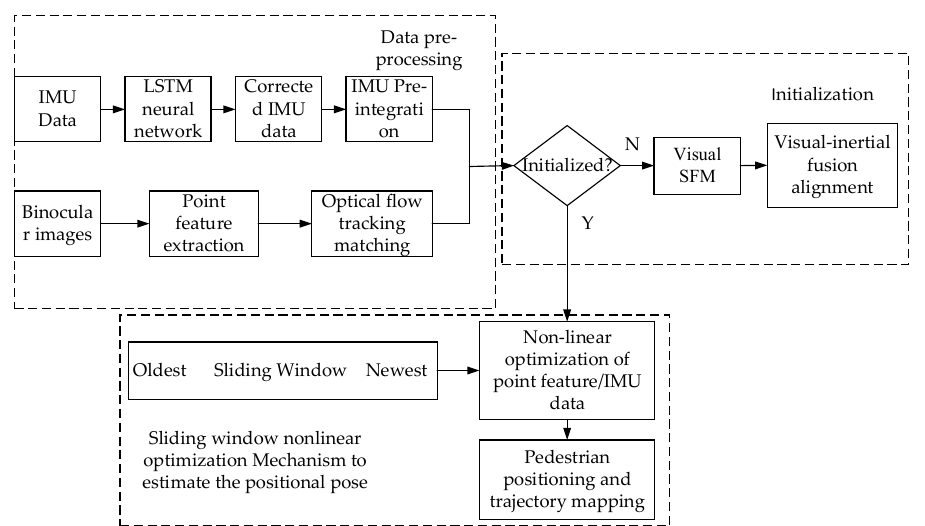
Figure 2. Neural network-assisted visual-inertial person localization framework diagram. The framework diagram is divided into three parts: data pre-processing, initialization, sliding window nonlinear optimization Mechanism to estimate the positional pose.